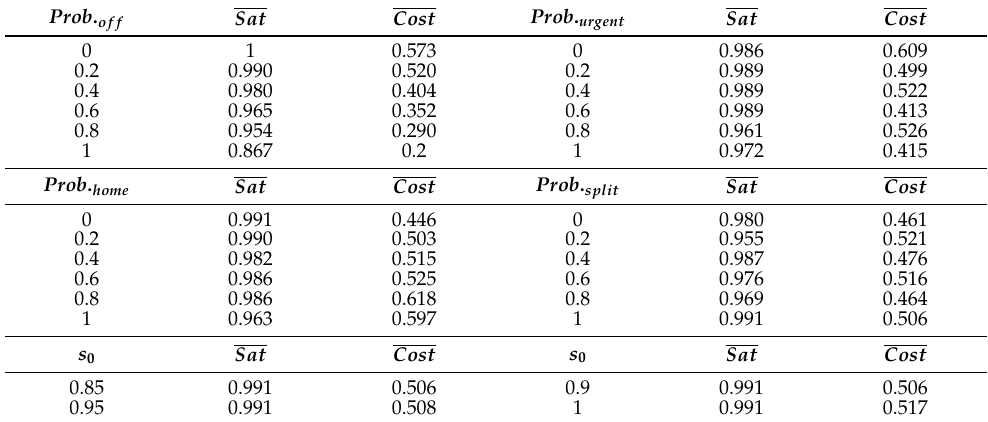
Table 9. Results of sensitivity